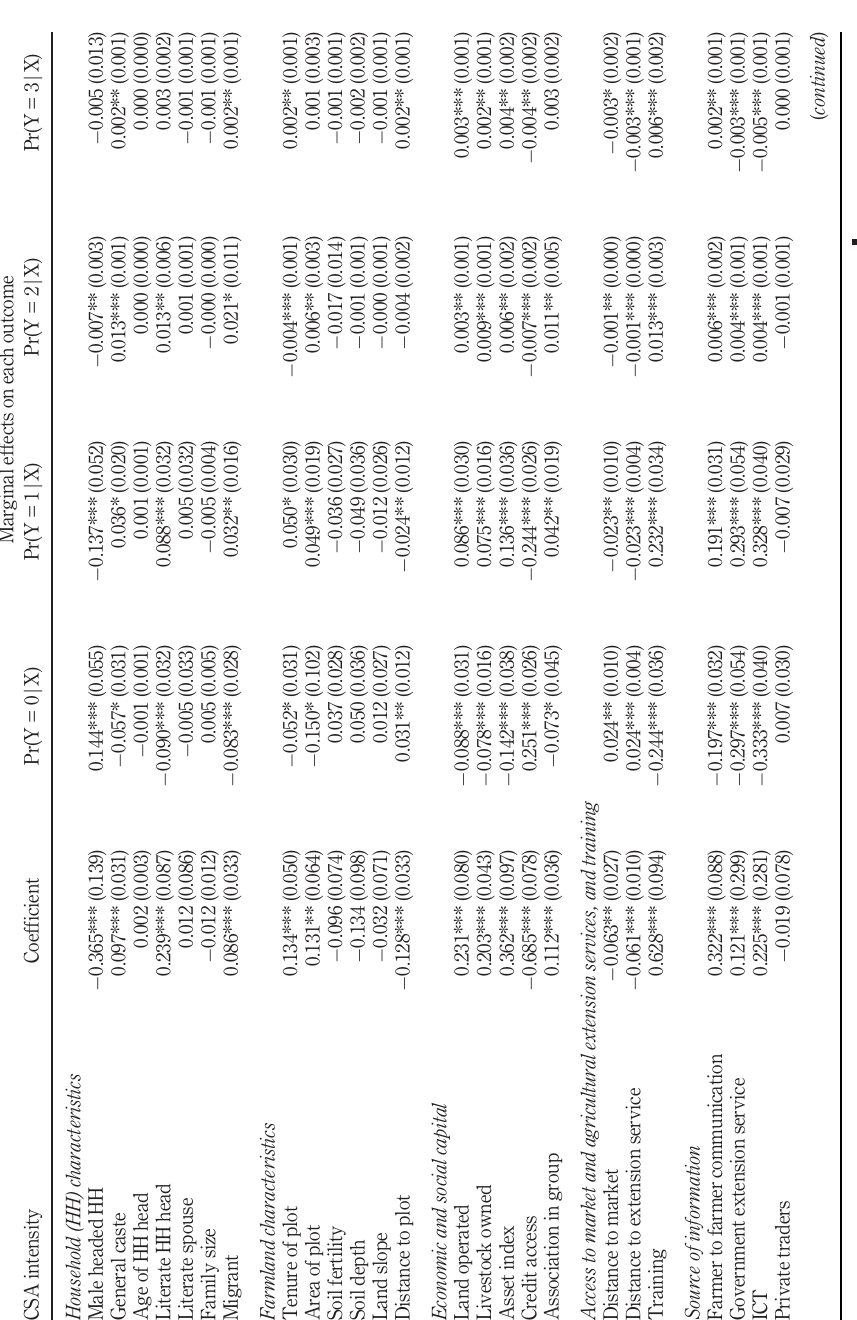
Table V. Estimates of the OP model and the marginal